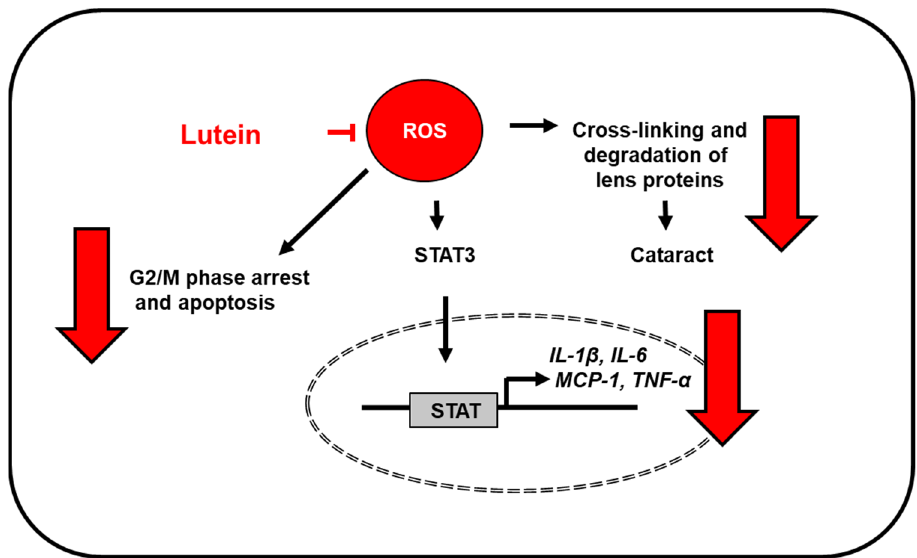
Figure 2. The proposed mechanism by which lutein inhibits oxidative stress-induced inflammatory responses in the eye. ROS levels increase in aged retina and lipopolysaccharide-stimulated retinal pigment epithelial cells. Lutein reduces ROS levels and inhibits ROS-mediated activation of STAT3 [7] and the expression of inflammatory mediators (IL-1 β , IL-6, MCP-1, TNF- α ) [7,49,57]. Thus, it prevents age-related macular degeneration. In addition, lutein prevents oxidative stress-mediated G2/M arrest and apoptosis in retinal pigmental epithelial cells [48] and cross-linking and degradation of lens proteins which prevents cataractogenesis [56]. IL, interleukin; MCP-1; monocyte chemoattratant protein-1; ROS, reactive oxygen species; STAT, signal transducer and activator of transcription; TNF- α , tumor necrosis factor- α